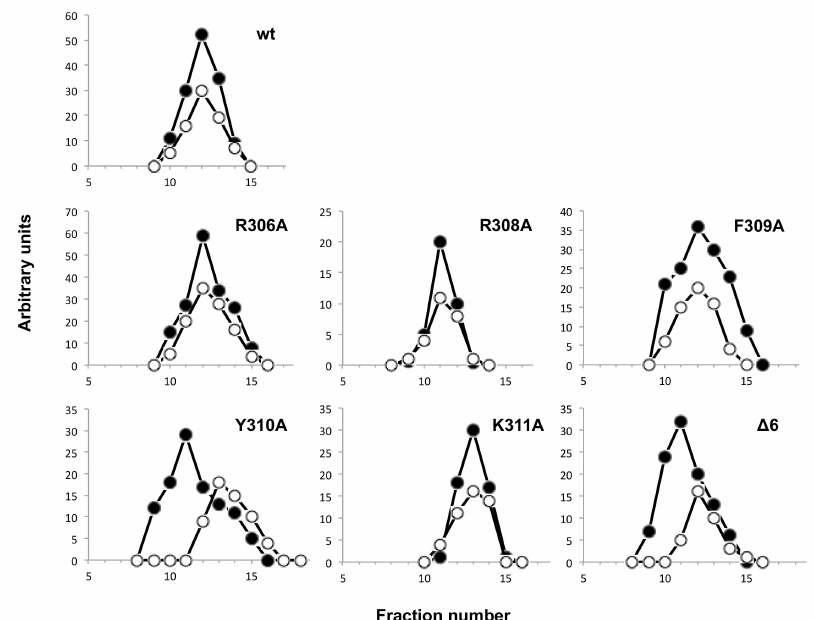
Figure 8. Analysis of TP / DNA polymerase interaction by glycerol gradient ultracentrifugation. The assay was carried out as described under Materials and Methods, preincubating 0.6 µ M of wild-type TP with 0.6 µ M of either the wild-type or the indicated mutant DNA polymerase. After incubation for 30 min at 4 ◦ C, samples were loaded on top of a continuous 15–30% glycerol gradient in the presence of 0.2 M NaCl. After centrifugation, the collected fractions were subjected to SDS-12% polyacrylamide gel electrophoresis and further stained with Coomasie. Densitometric quantification, expressed in arbitrary units, of both DNA polymerase (full circles) and TP (open circles), is represented. Once catalyzed the formation of the TP-dAMP product, the same DNA polymerase molecule elongates it via strand displacement to produce full-length Phi29 TP-DNA [9]. Thus, replication assays were carried out using a minimal replication system based on Phi29 TP-DNA, DNA polymerase, and TP [9]. As it can be observed in Figure 9 and Table 1, mutants R308A, F309A, and K311A were moderately a ff ected, whereas mutant R306A and particularly Y310A were severely impaired in the replication reaction, in agreement with their hindered initiation activity. As expected, the deletion of the TPR1 loop in mutant ∆ 6 precluded the replication of TP-DNA.